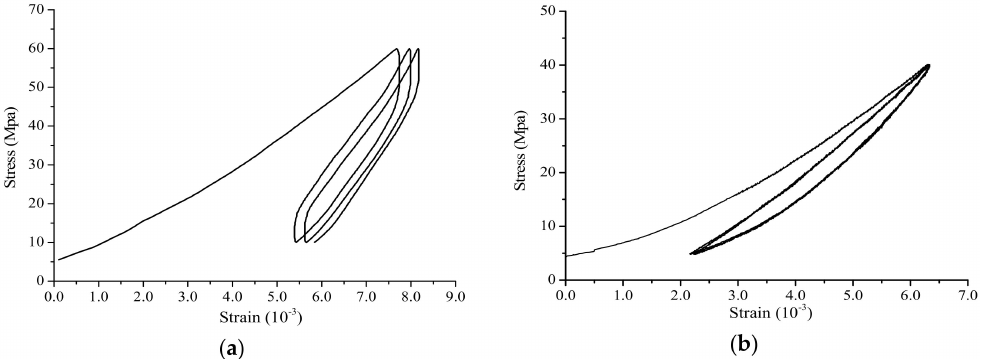
Figure 2. Stress–strain curves for samples: ( a ) HG-1; ( b ) SY-1.